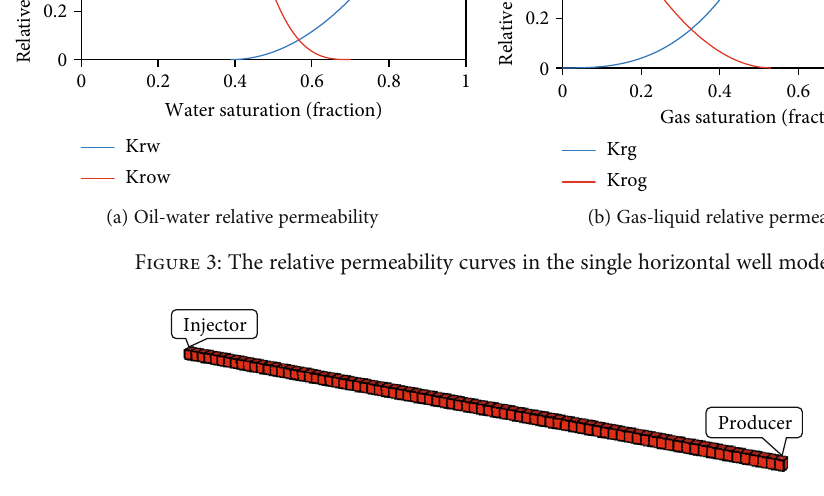
Figure 4: Schematic of the slim tube model.